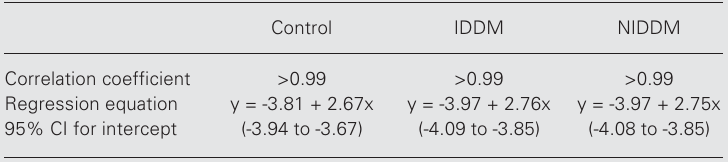
Table 2. Parameters of the Hill plots and oxygen dissociation curves.